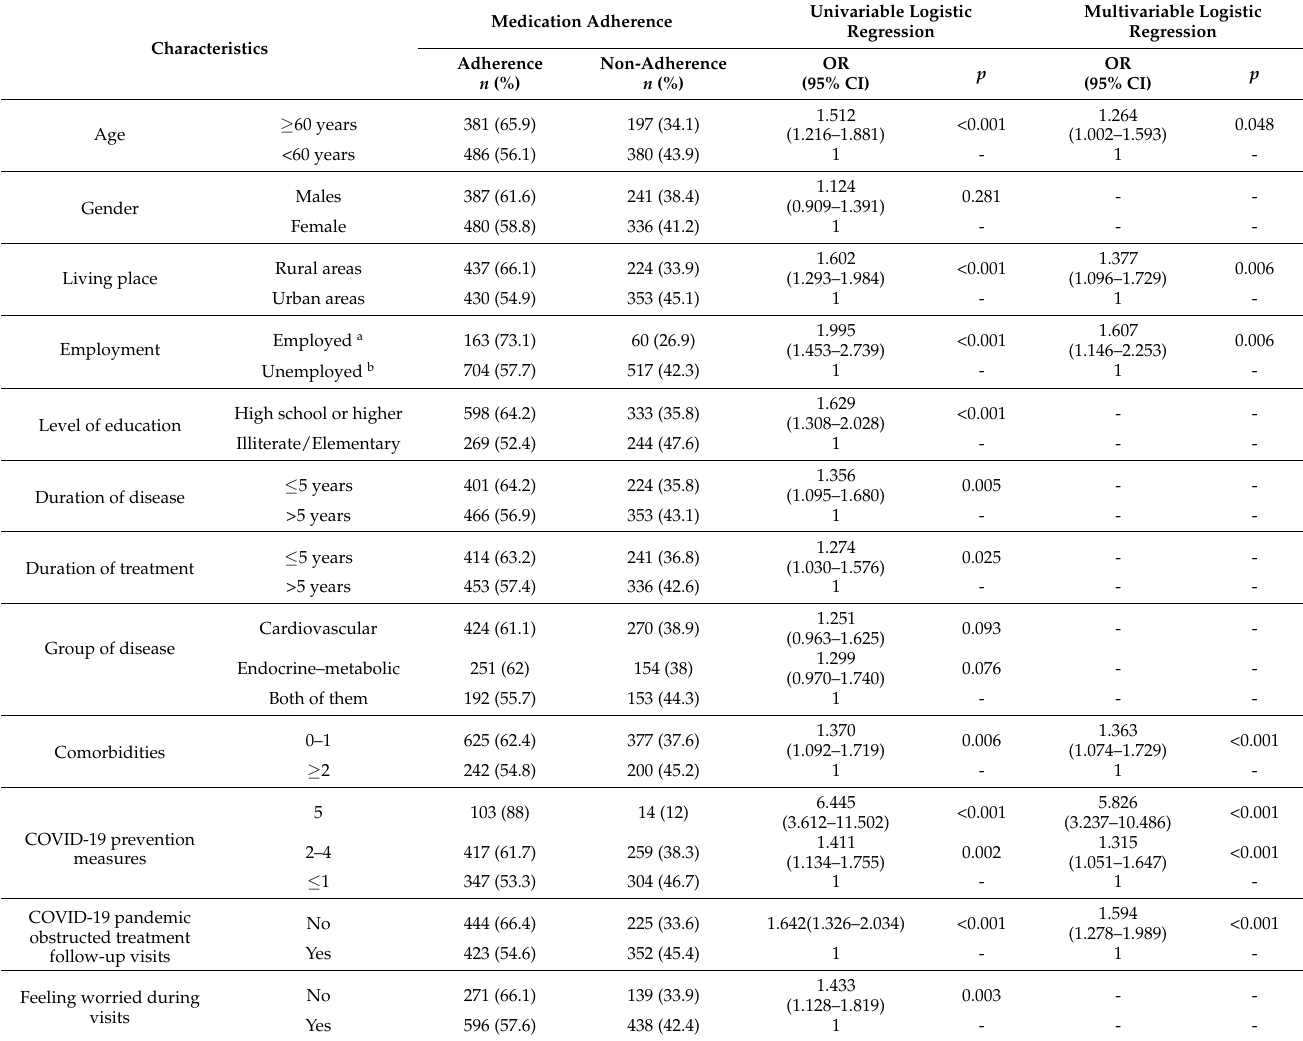
Table 5. The relationship between patient characteristics and medication